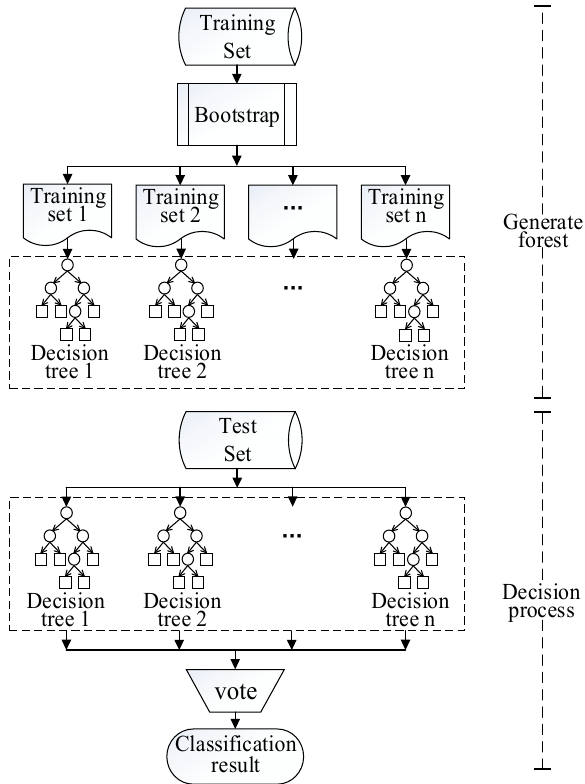
Figure 3. Schematic diagram of random forest algorithm.